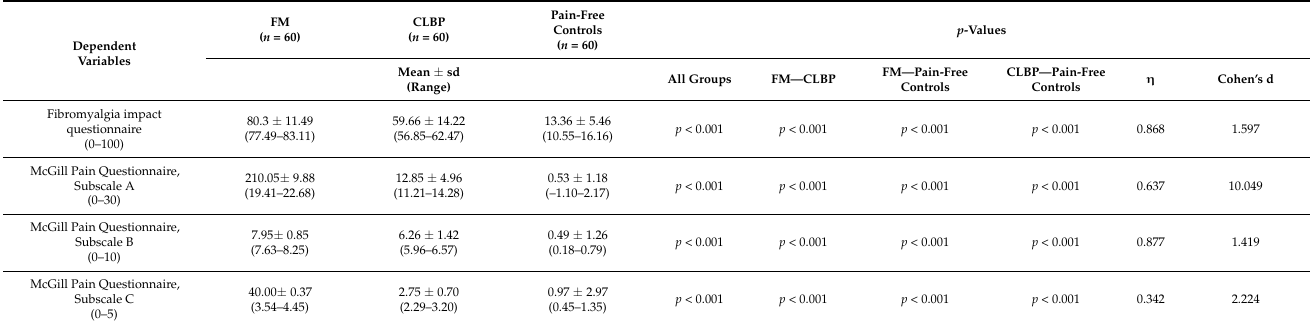
Table 2. Comparisons among the three groups of participants on somatosensory sensitivity, motor function, and balance.